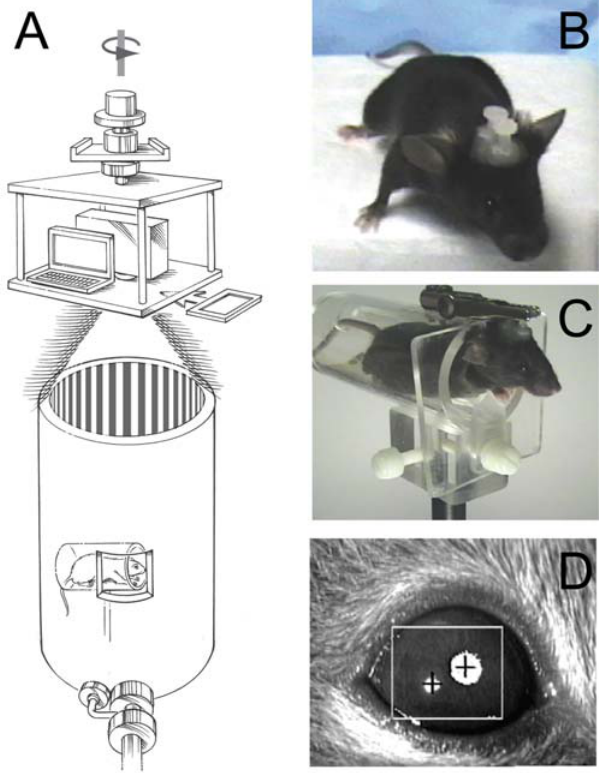
Figure 1. OKR apparatus and testing arrangement. (A) The mouse is held in a horizontal acrylic cylinder within a large cylindrical drum. A small transparent zone in the wall of the drum allows an infrared (IR) light source and camera (bottom, in foreground) to monitor eye movements. The stimulus is controlled by a laptop computer and a projector, both of which sit approximately two meters above the drum on a rotating table that is controlled by a variable speed motor (not shown). Neutral density or chromatic filters can be placed in the light path (rectangle, at right). (B) A headposted mouse with two plastic nuts set along the anterior posterior axis. (C) A headposted mouse in position for OKR measurements rests in the acrylic cylinder with its head protruding and immobilized by an alligator clip. (D) IR image of a mouse eye showing the pupil (large upper right white circle with centered cross) and the corneal reflection (lower left white circle with centered cross). The ISCAN software has assigned the IR sink as the pupil and the IR peak as the corneal